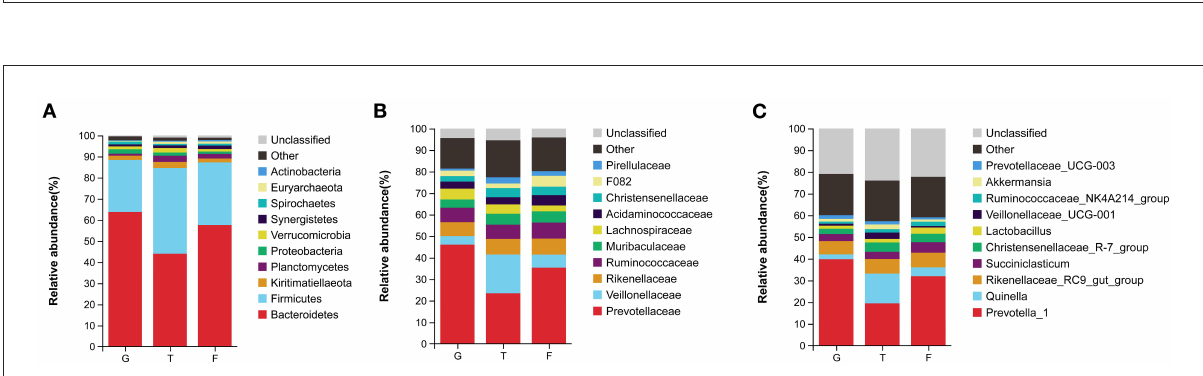
FIGURE2 Comparisons of ruminal bacteria in Gangba sheep under different feeding strategies. (A) Relative abundances of bacterial communities at the phylum level. (B) Relative abundances of bacterial communities at the family level. (C) Relative abundances of bacterial communities at the genus level. G, natural grazing; T, semi-grazing with supplementation; F, barn